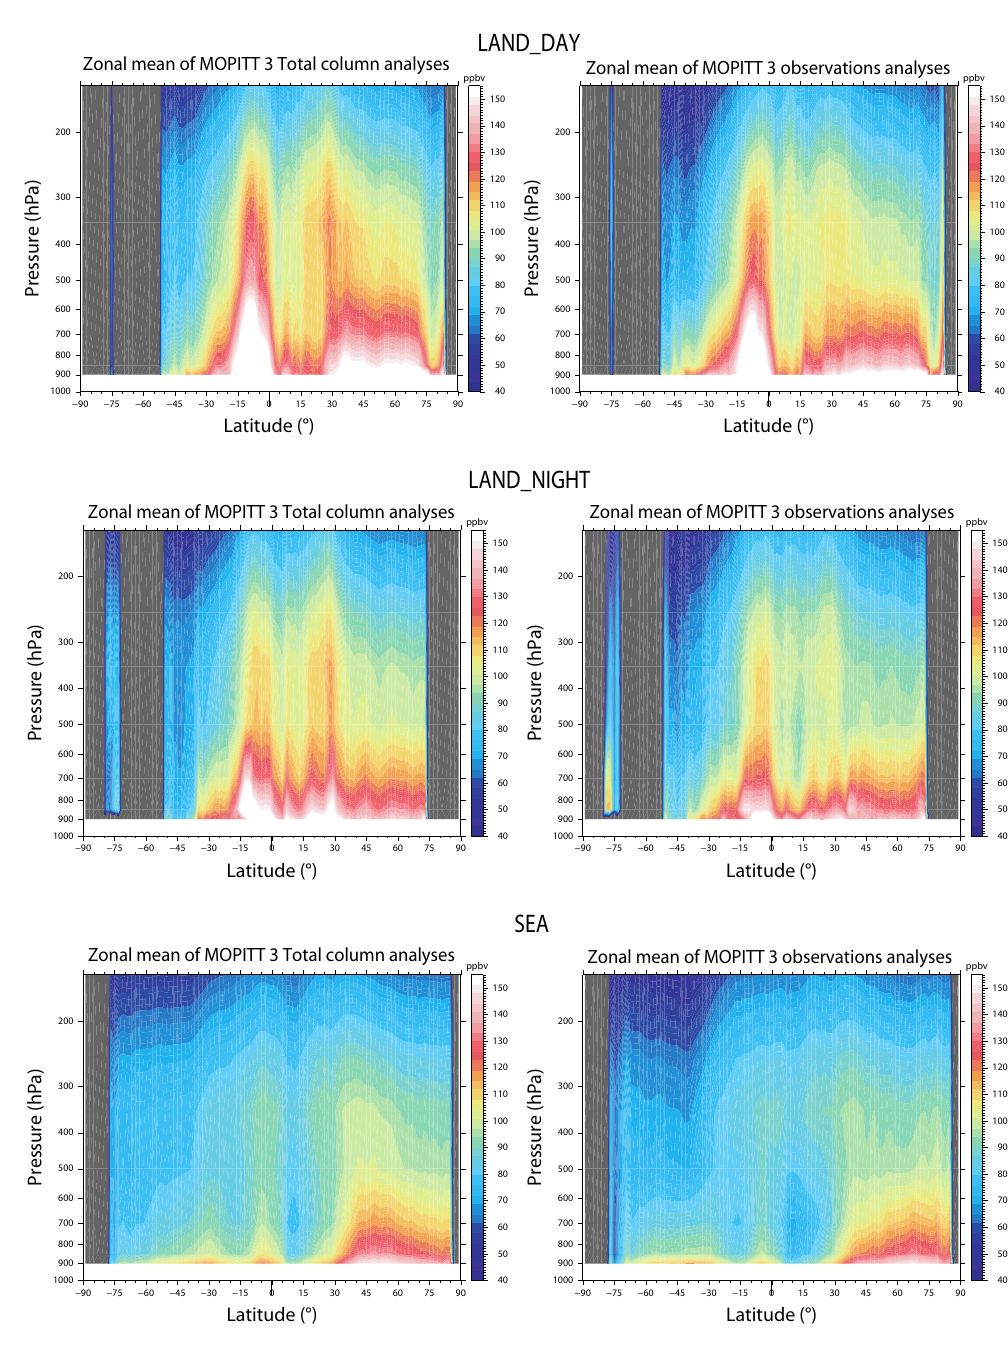
Figure 5. Zonal mean of MOPITT CO TOTCOL_ANALYSES (left panels) compared to the zonal mean of the MOPITT CO observations Fig. 5. Zonal mean of MOPITT CO TOTCOL ANALYSES (left panels) compared to the zonal mean of the (right panels) for August 2008. The comparison is done for observations made over land during daytime (upper panel), over land during MOPITT CO observations (right panels) for August 2008. The comparison is done for observations made: night-time (middle panel) and over sea during daytime and night-time (bottom over land during daytime (upper panel), over land during nighttime (middle panel) and over sea during daytime and nighttime (bottom panel).